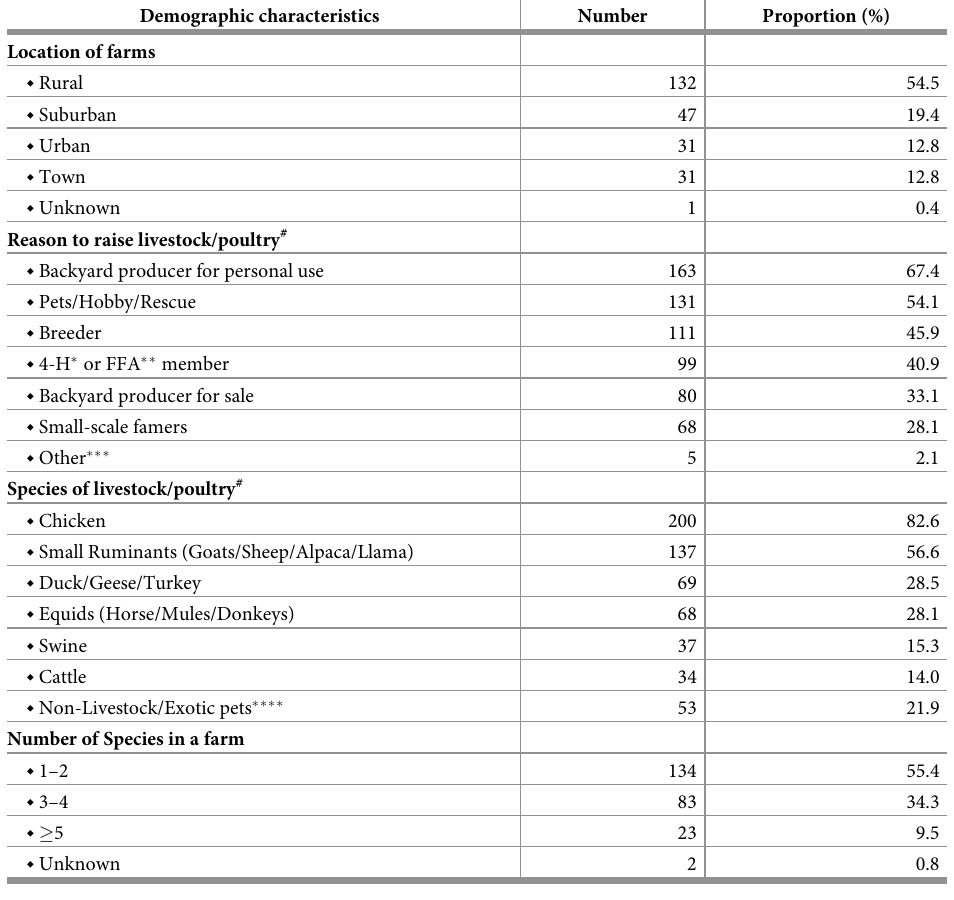
Table 1. Summary of farm demographics of the survey respondents (n =